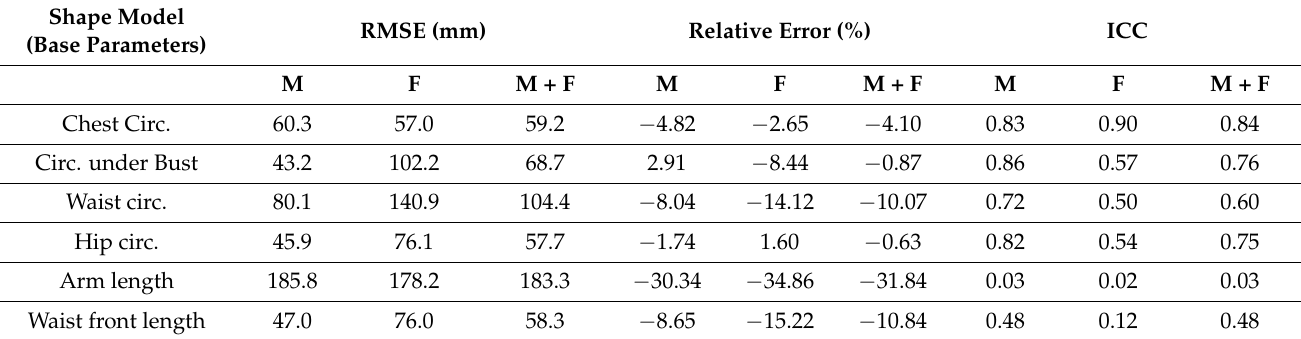
Table 3. Overview of the results of the shape model prediction based on the base parameter inputs.